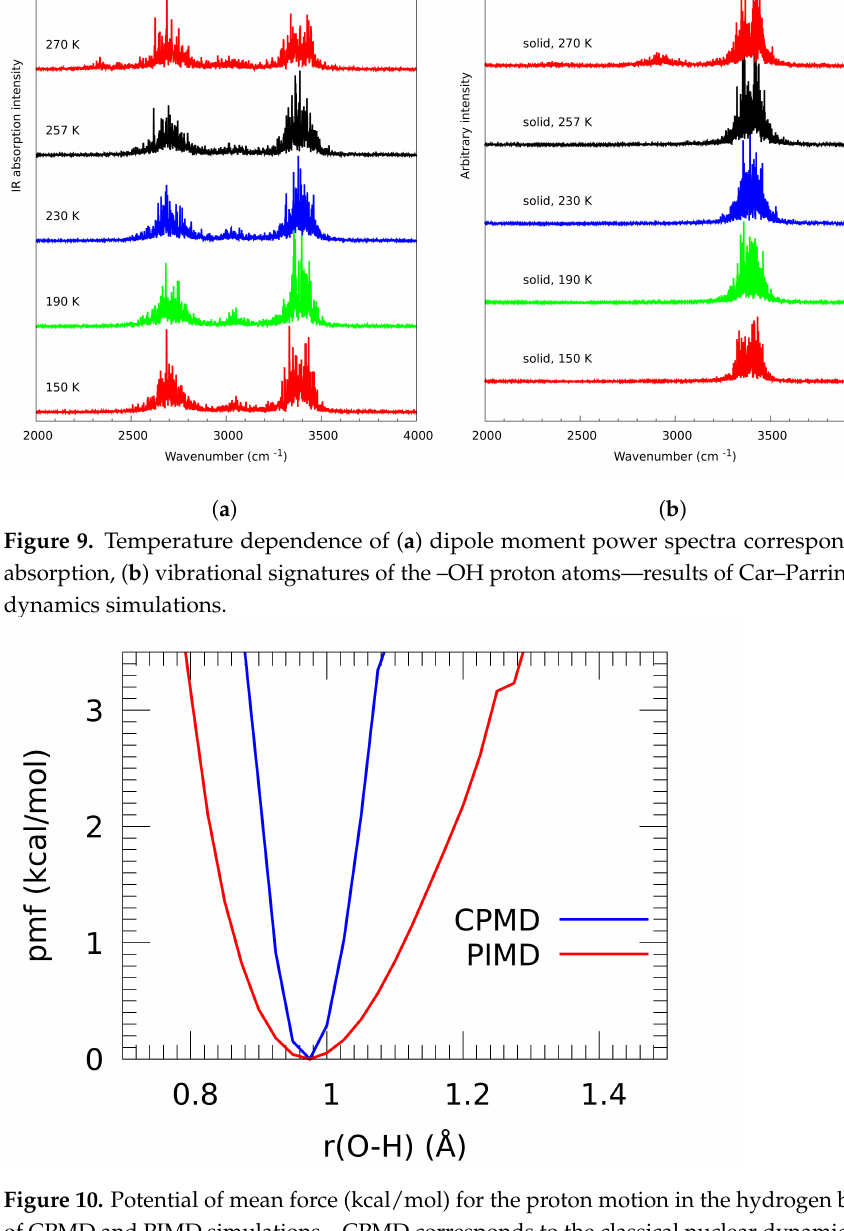
Figure 10. Potential of mean force (kcal/mol) for the proton motion in the hydrogen bridge. Results of CPMD and PIMD simulations—CPMD corresponds to the classical nuclear dynamics, while PIMD incorporates nuclear quantum